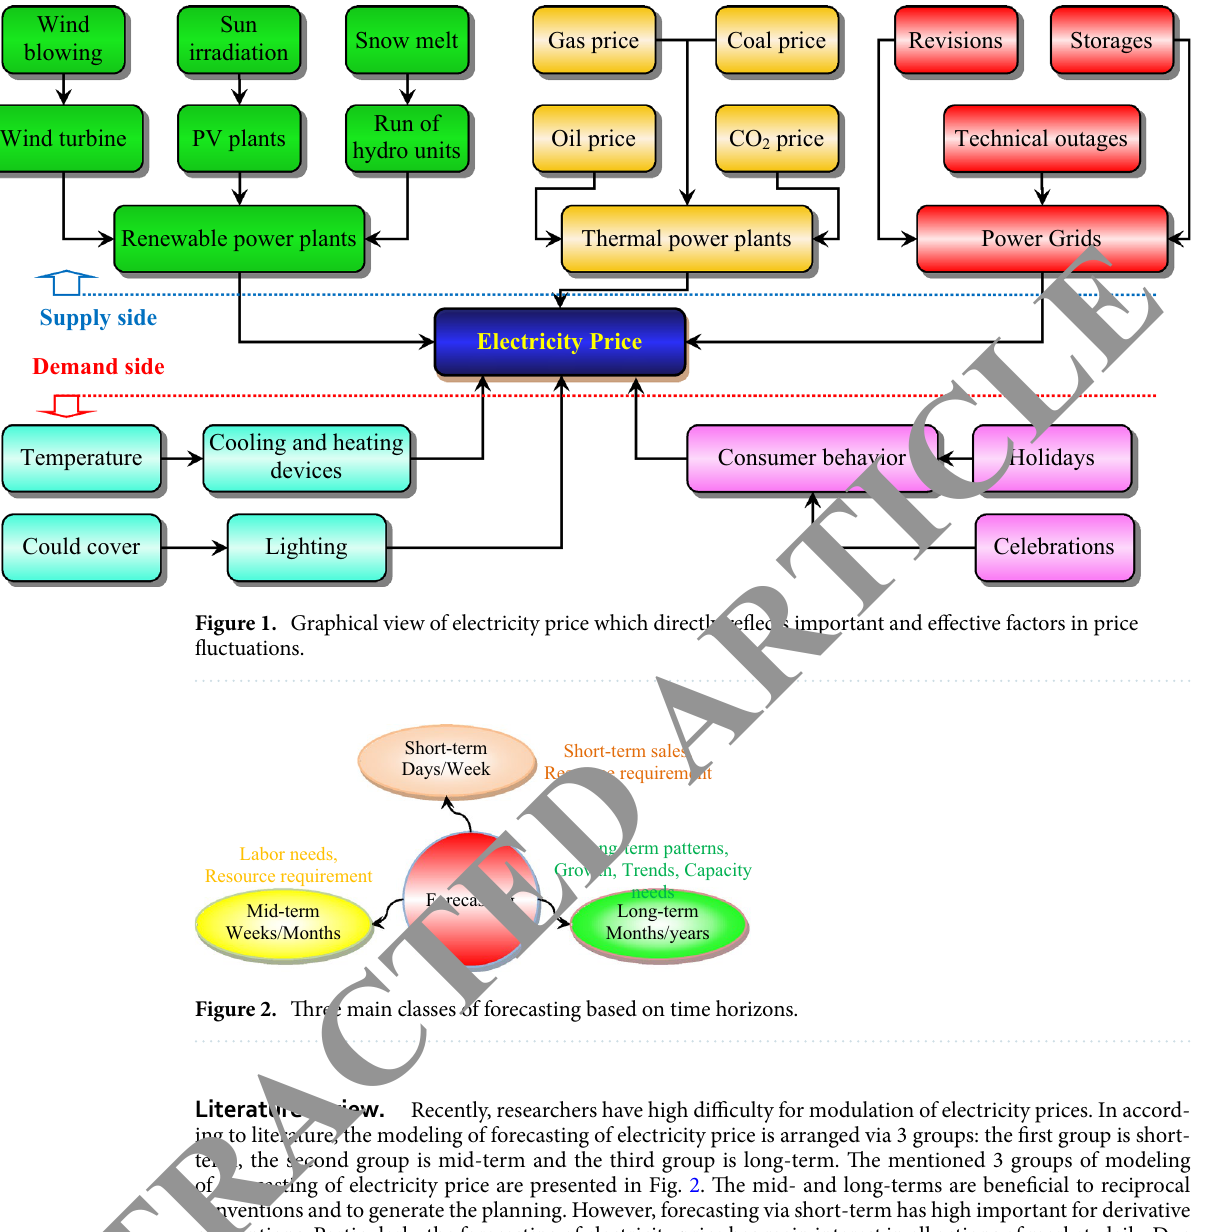
Figure 2. Three main classes of forecasting based on time